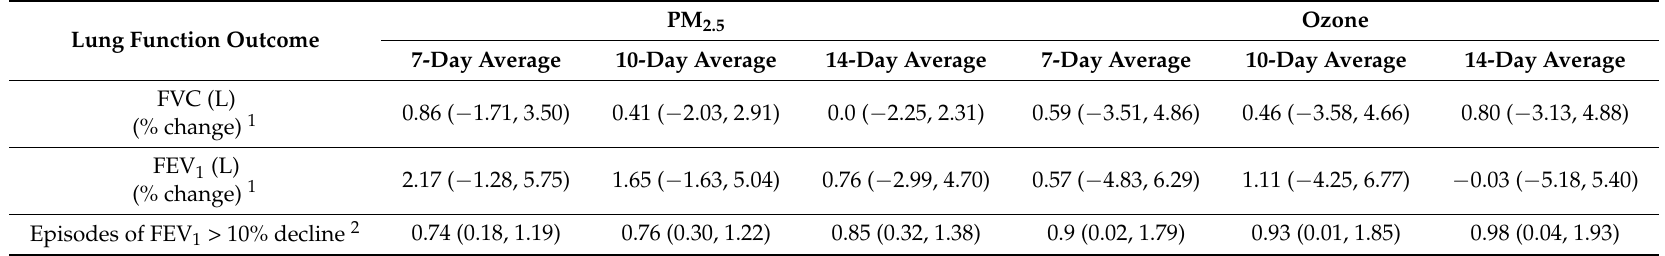
Table 3. Association between air pollution exposure and lung function outcomes.